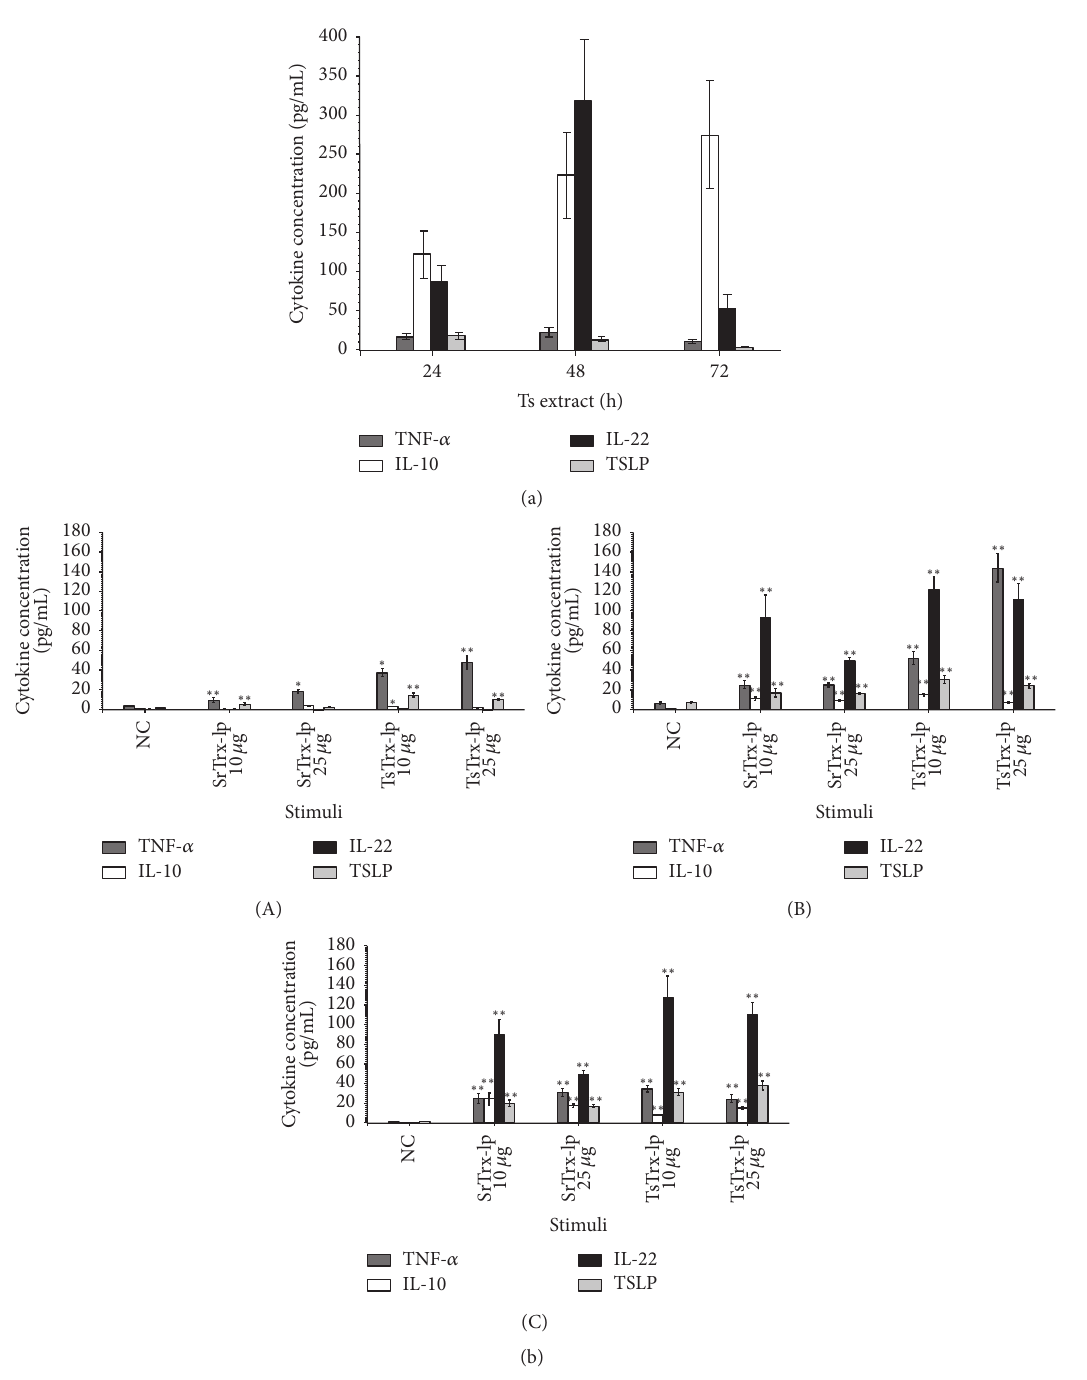
Figure 6: (a) Exposure of 3D-cocultures to Trichuris suis (Ts) extract. Culture supernatants were harvested after 24h, 48 h, and 72 h. The release of inflammatory (TNF- 𝛼 ), anti-inflammatory (IL-10), and T H 2 -related cytokines (IL-22, TSLP) was analyzed in a 3D-cell culture model. Representative results of at least three independent experiments are shown as median. (b) Exposure of 3D-cocultures to SrTrx- and TsTrx-lp or medium (NC). Culture supernatants were harvested after 24 h (A), 48 h (B), and 72h (C). The release of inflammatory (TNF- 𝛼 ), anti-inflammatory (IL-10), and T H 2 -related cytokines (IL-22, TSLP) was analyzed in a 3D-cell culture model. Representative results of at least three independent experiments are shown. Significant increase of all measured cytokines compared to NC ( ∗∗ 𝑃 < 0.01 ). ∗ 𝑃 < 0.05 ; ∗∗ 𝑃 < 0.01